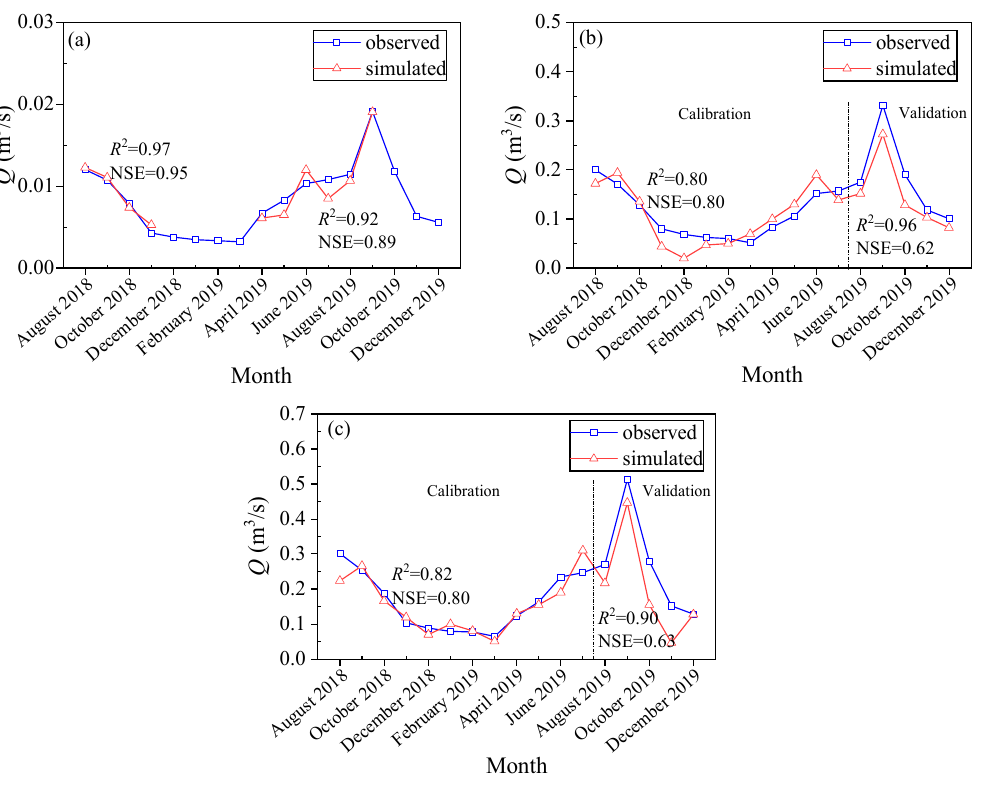
Figure 5. Calibration and validation results based on land use scenario in 2019; ( a ) upstream point, ( b ) midstream point, ( c ) downstream (outlet) point.